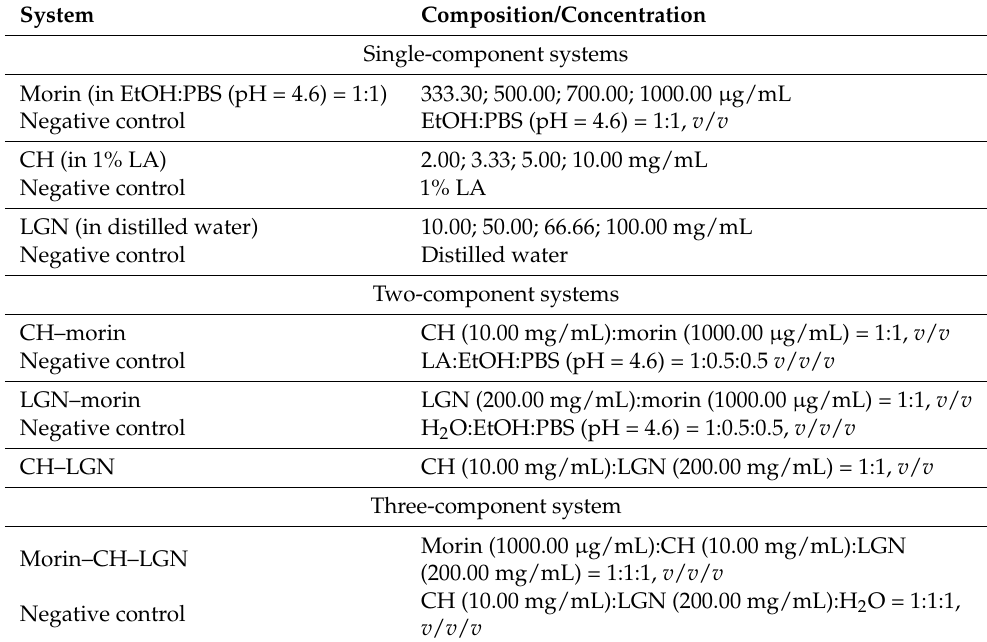
Table 2. Compositions of the studied single-, two- and three-component